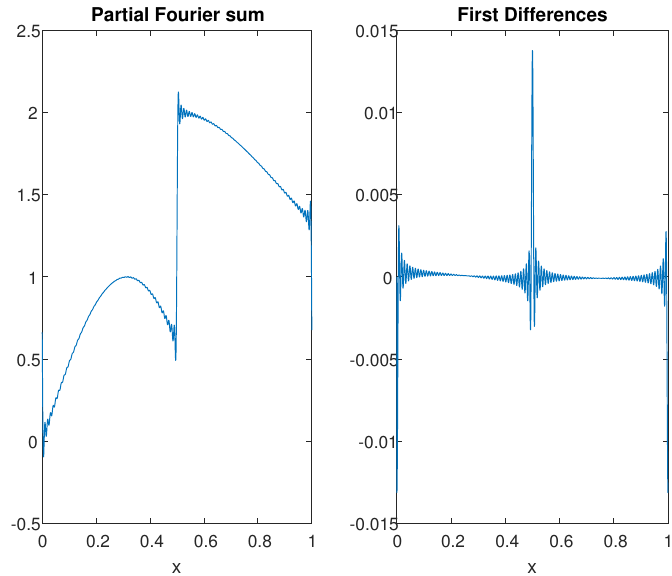
Figure 4. A partial Fourier sum ( left ) and its first differences ( right ).